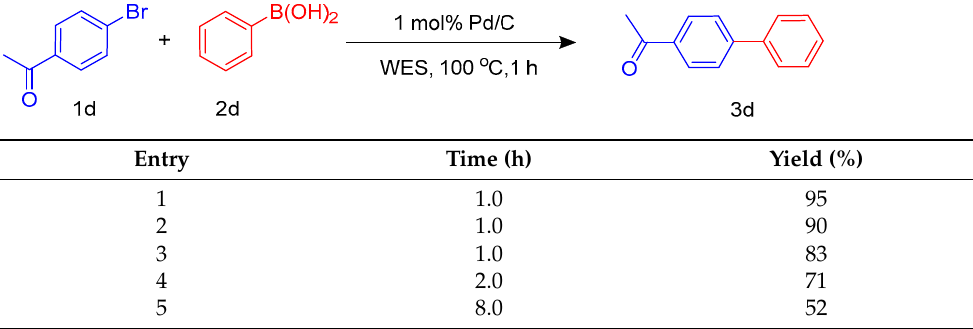
Table 3. Catalyst recovery of Suzuki–Miyaura reaction with Suaeda salsa extract as solution.